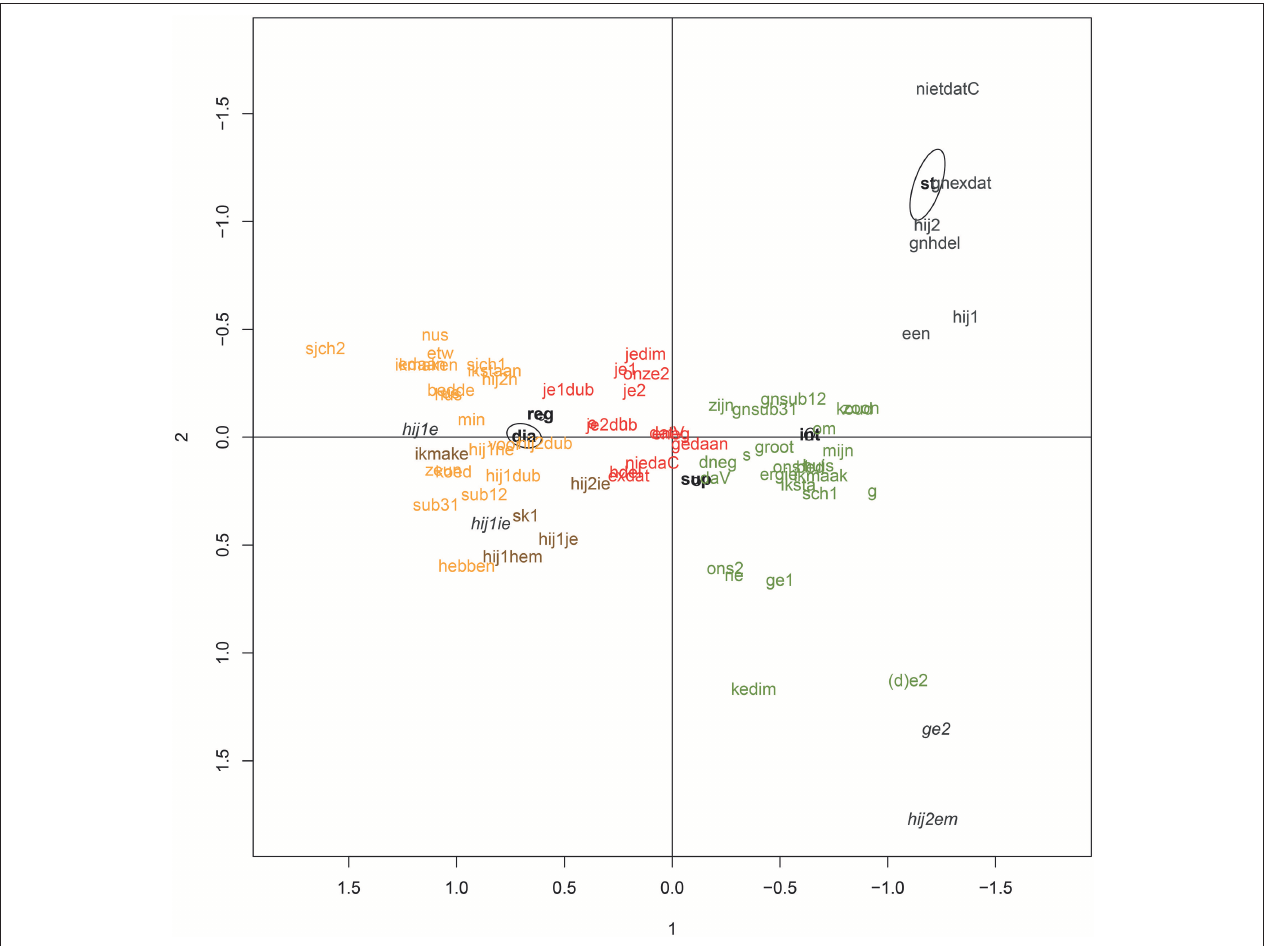
FIGURE 4 | Correspondence plot Ieper with main effects for situation; the color codes indicate how the variants are categorized in a cluster analysis based on four-dimensional correspondence coordinates.